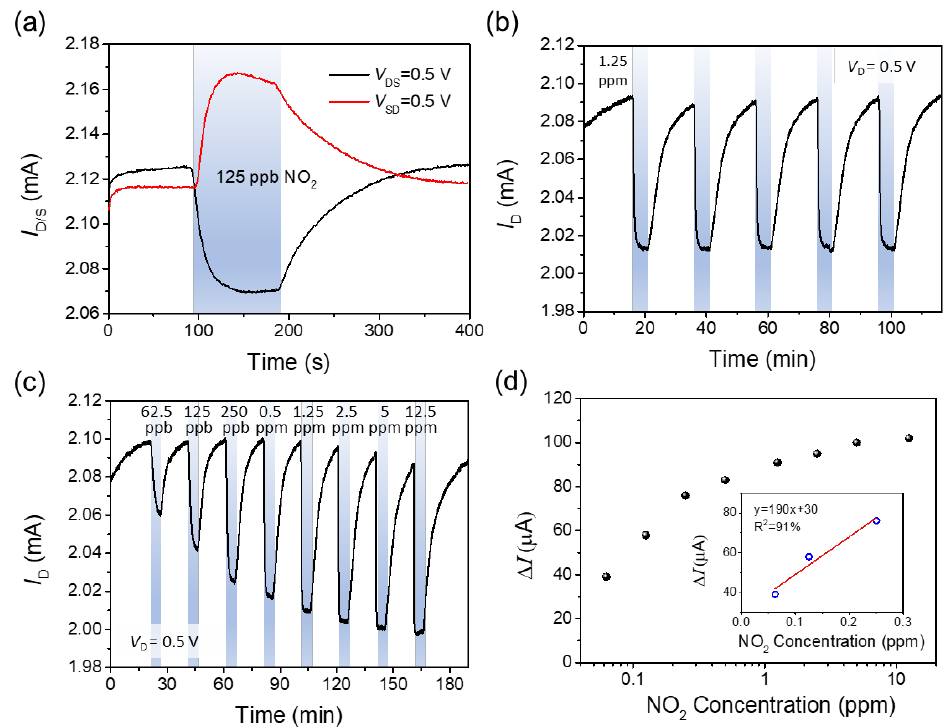
Figure 3. Sensing properties of the gas sensor. ( a ) Response curves of the sensor to 125 ppb NO 2 ; Response curves of the gate-sensitive HEMT gas sensor to ( b ) 1.25 ppm and ( c ) 62.5 ppb~12.5 ppm NO 2 ; ( d ) Relationship between the response of the sensor and the concentration of NO 2 .